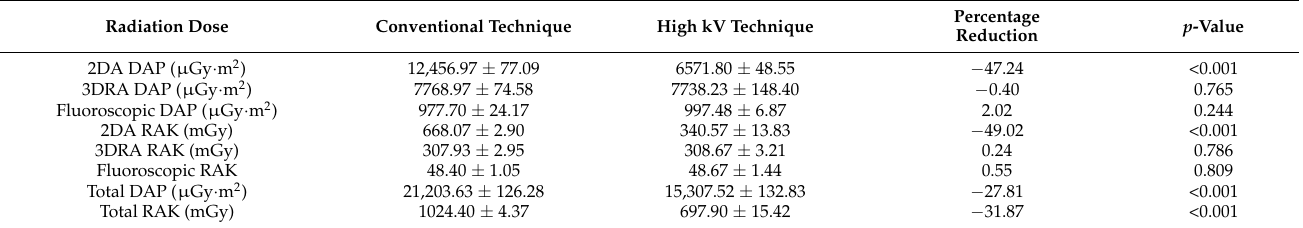
2DA = 2-dimensional angiography; 3DRA = 3-dimensional rotational angiography; DAP = dose area product; and RAK = reference air